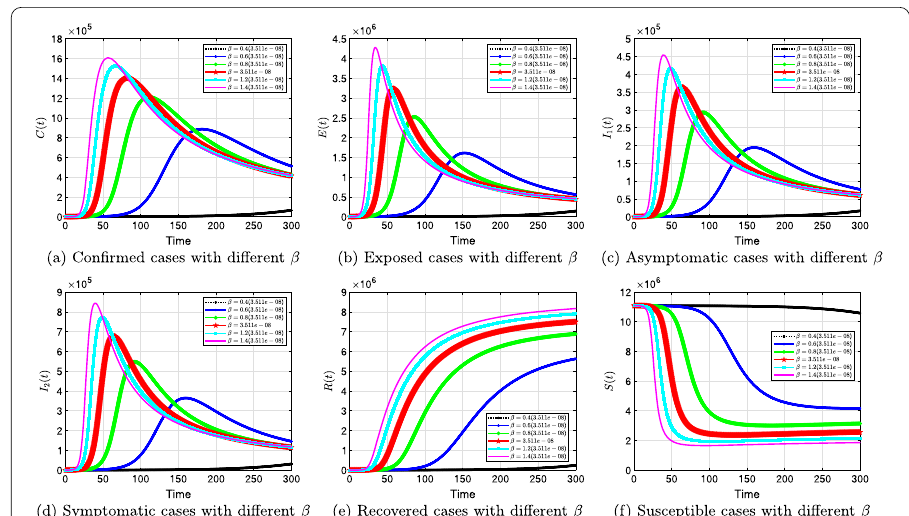
Figure 9 Solution profiles for the COVID-19 model with different β when α = 0.7